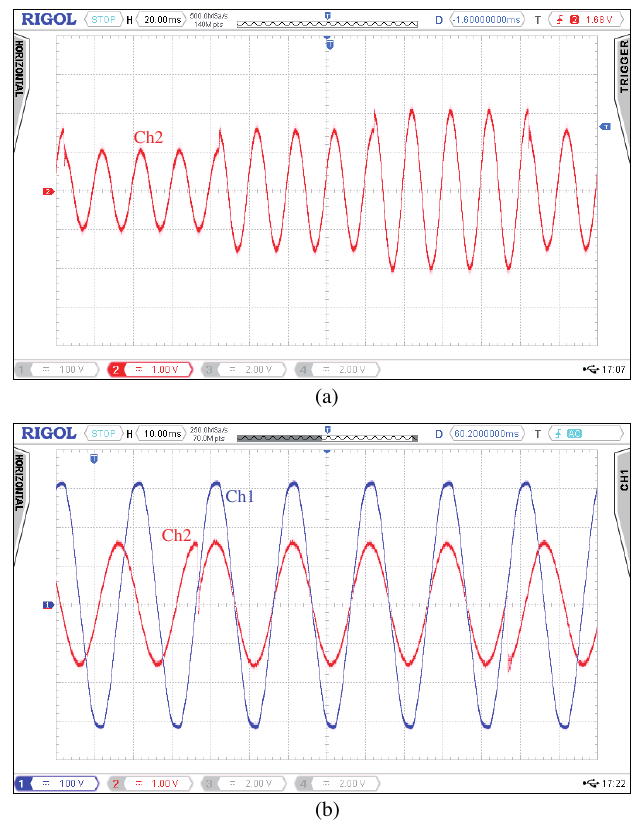
Figure 16. Grid current response of the IPCC + CE against reference variations in: ( a ) amplitude; and ( b ) phase. Ch1: grid voltage (100 V/div); Ch2: grid current (10